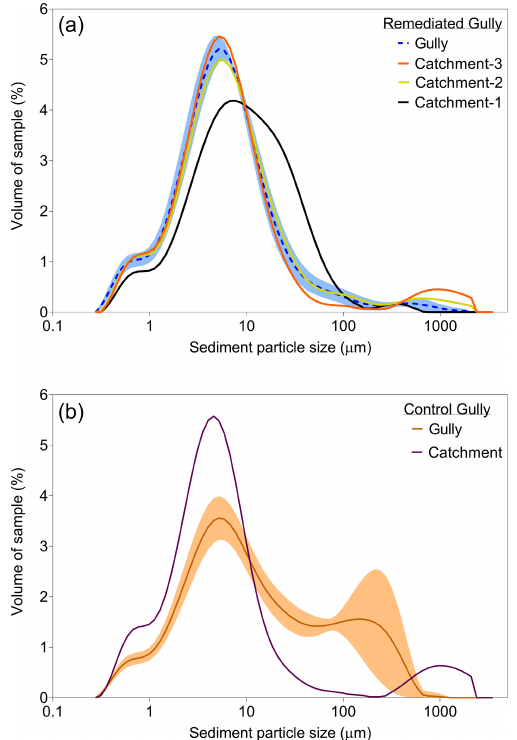
Figure 9. Average PSDs of PASS samples collected from the reme- diated gully (blue) and catchments (orange, yellow, and black) and control gully (brown) and catchment (purple) suspended sediment PSD frequency plots during the 2018–2019 wet season. Shading around gully PSDs represents the error as a standard